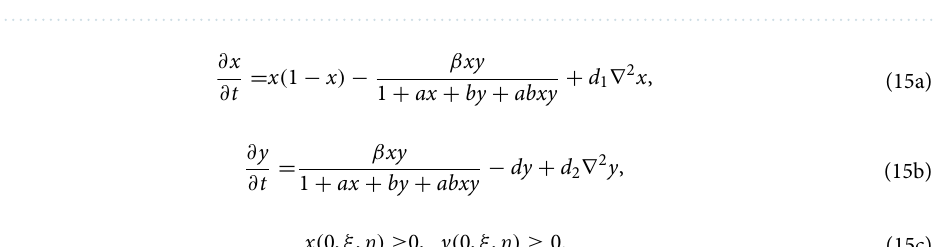
E E 0 and 3 are separated by those two